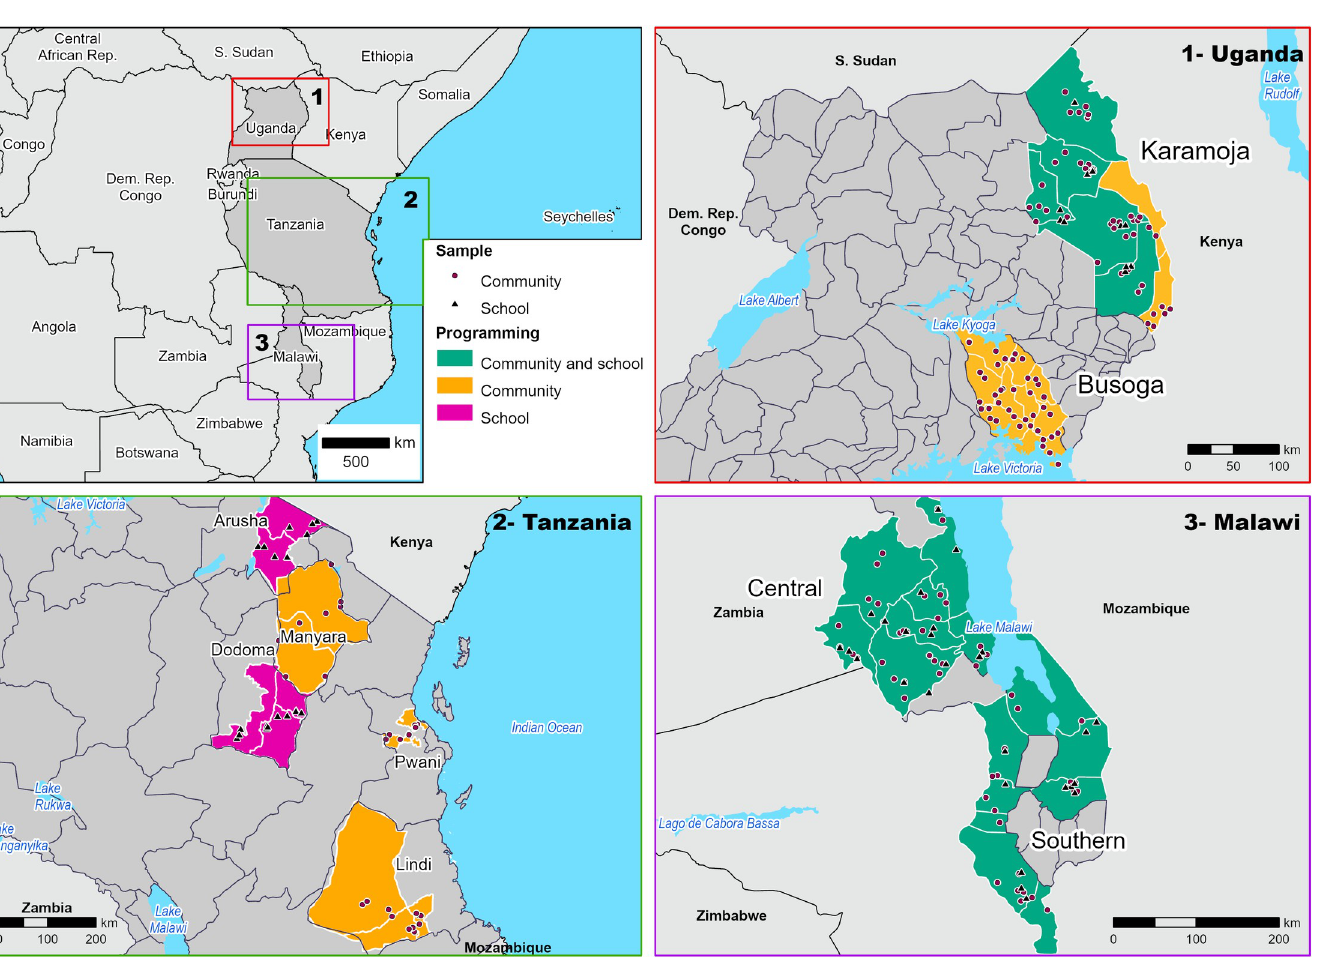
Fig 1. Location of F&E interventions and sampled villages and schools for pre and post-survey. Base map is from NaturalEarth for administrative boundary https:// www.naturalearthdata.com/downloads/10m-cultural-vectors/ and for lake layer